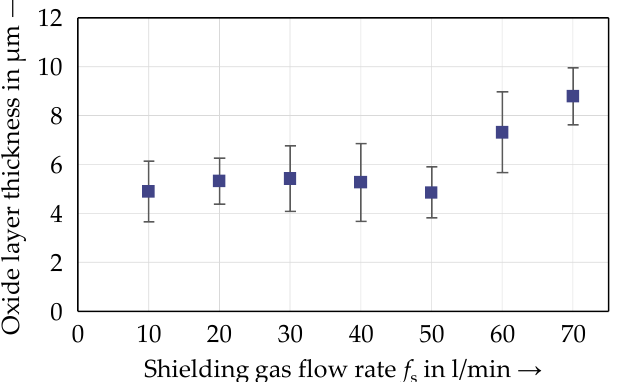
Figure A1. Measured oxide layer thicknesses of the individual weld beads deposited using the lateral shielding gas nozzle; for each shielding gas flow rate, the average of twelve measurements distributed over the weld bead cross-section was determined.